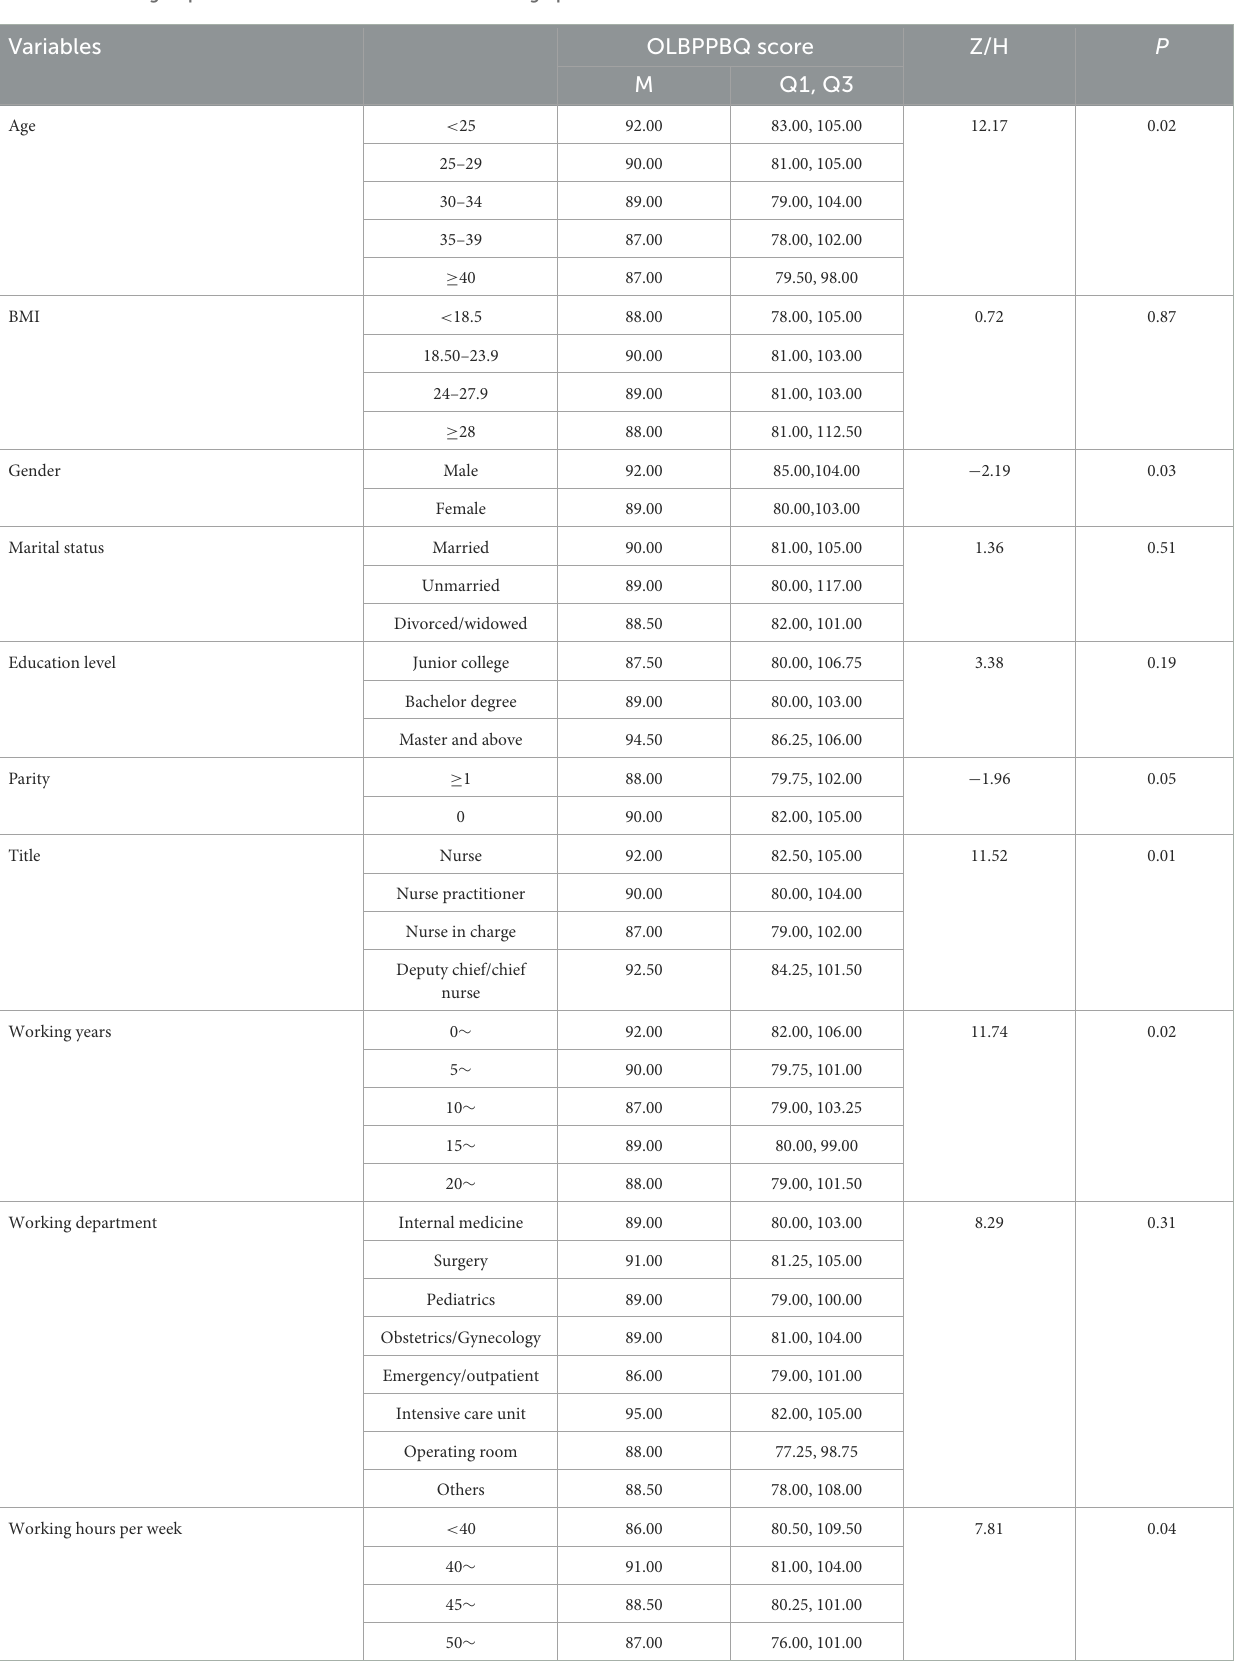
TABLE 3 Between-group differences in OLBPPBQ scores of demographic